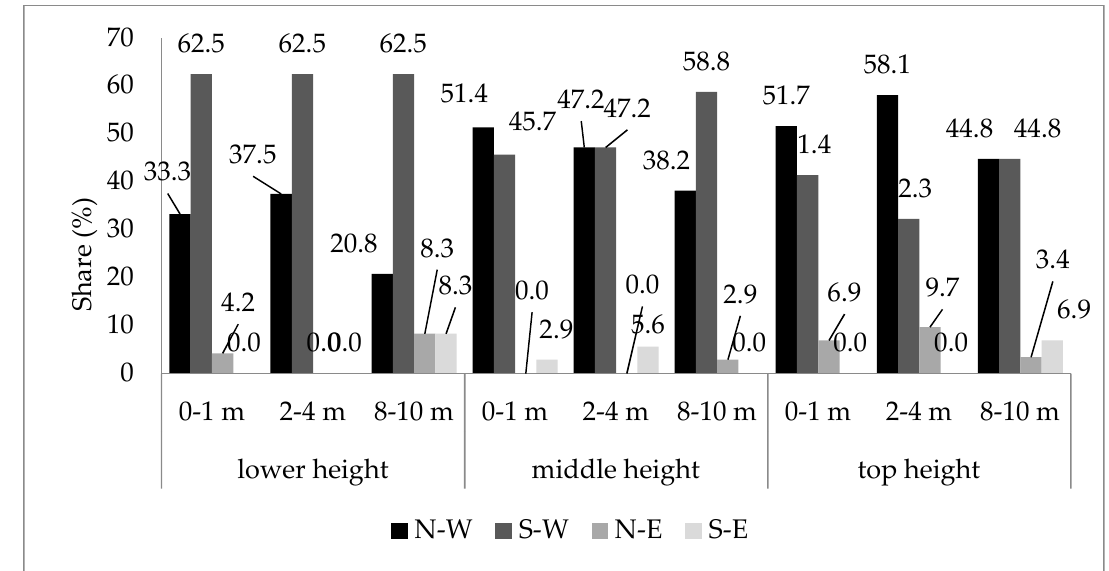
Figure 4. Stem pith shifts related to height of measurement in the 3.5 m variant, in different (0–1, 2–4, 8–10 m) distance zones from the strip road.